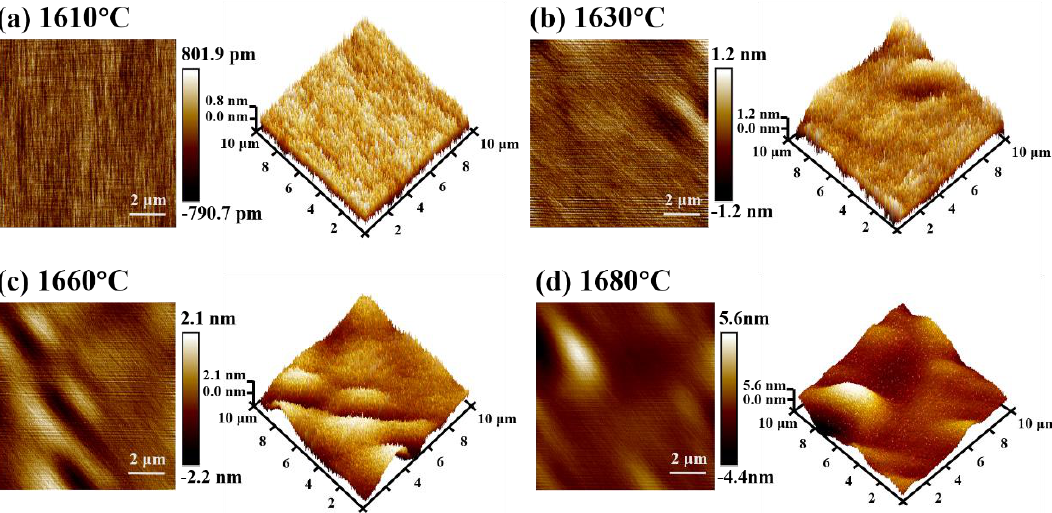
Figure 3. 2D and 3D AFM images of 4H-SiC wafers at the growth temperature of: ( a ) 1610 °C, ( b ) 1630 °C, ( c ) 1660 °C, and ( d ) 1680 °C.